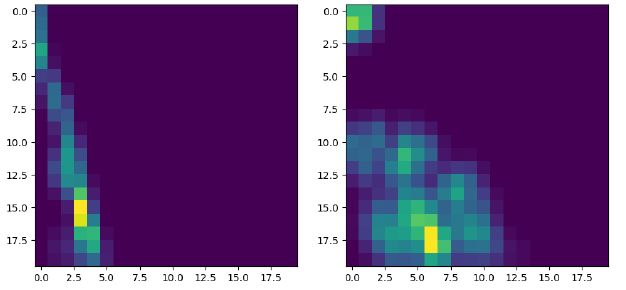
Figure 11. Characteristic persistence images before ( left ) and after ( right )